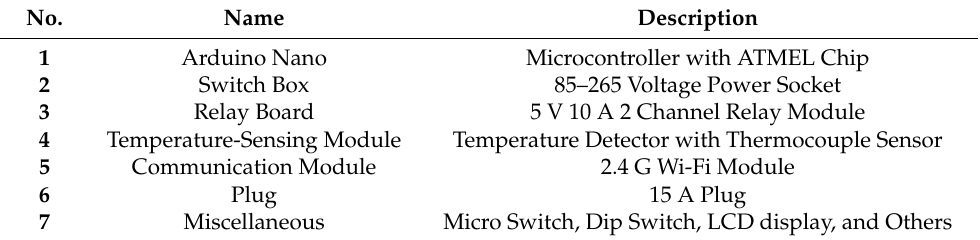
Table 2. Adopted electronic components and their specifications in this work. No.